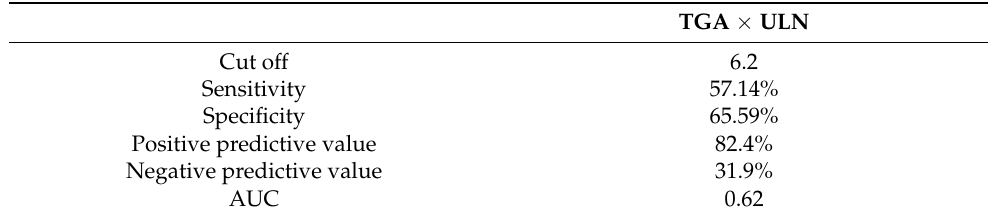
Figure 2. Receiver operating characteristic (ROC) curve referring to TGA normalized per ULN. Table 3. Sensitivity, specificity, and positive and negative predictive value, area under the curve (AUC) of TGA normalized per